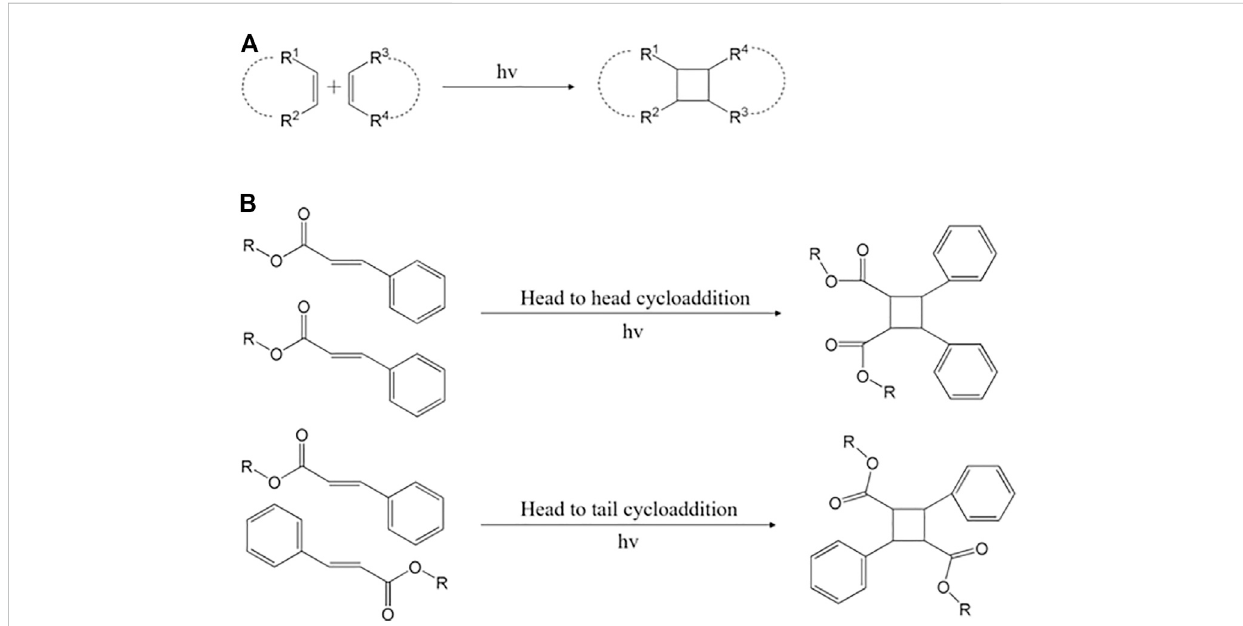
FIGURE 5 Brief mechanism of (A) cyclobutane and (B) (2 + 2) photocycloaddition (Gupta et al., 2004; Sarkar et al.,